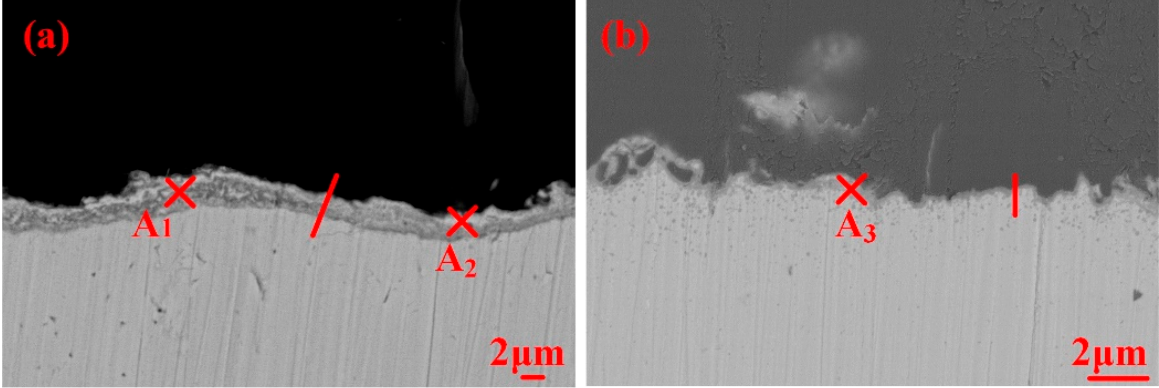
Figure 9. The interfacial structure of different Ti contents at the optimal parameters. ( a ) 6 wt.%, ( b ) 7.5 wt.%. Table 3. EDS results of marked points in Figure 9 (at.%).